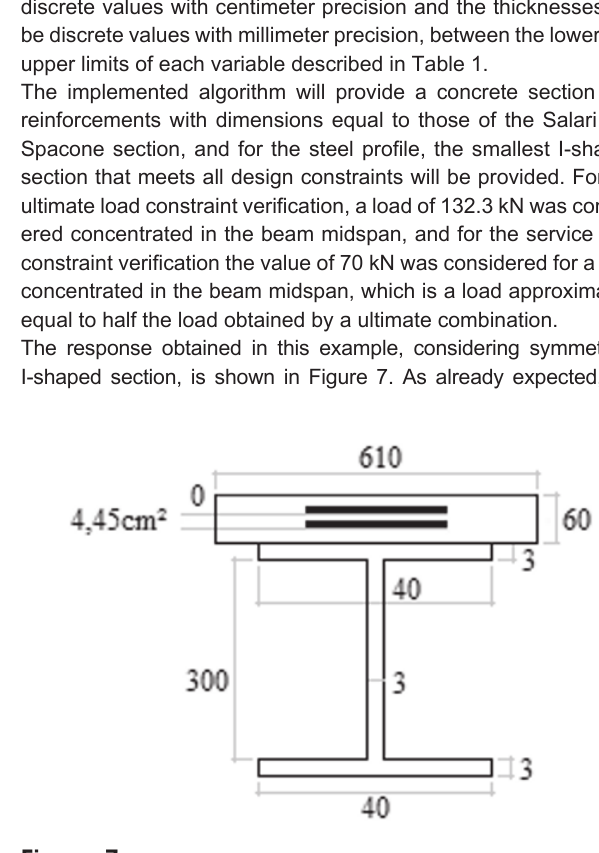
Optimized symmetric section obtained by the algorithm (dimensions in